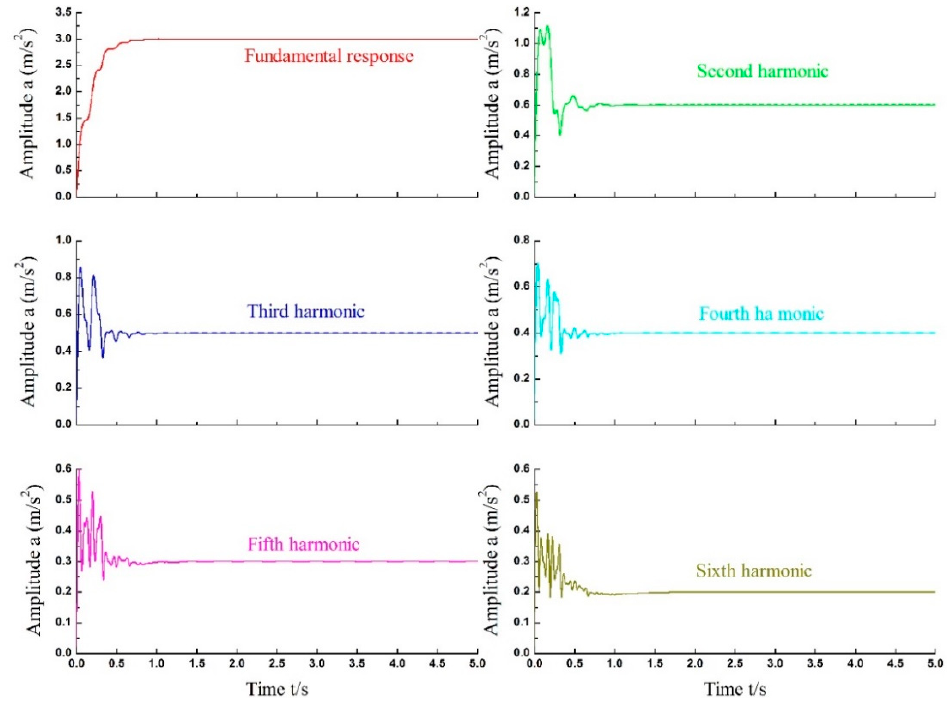
Figure 8. Estimation amplitudes of simulation results.